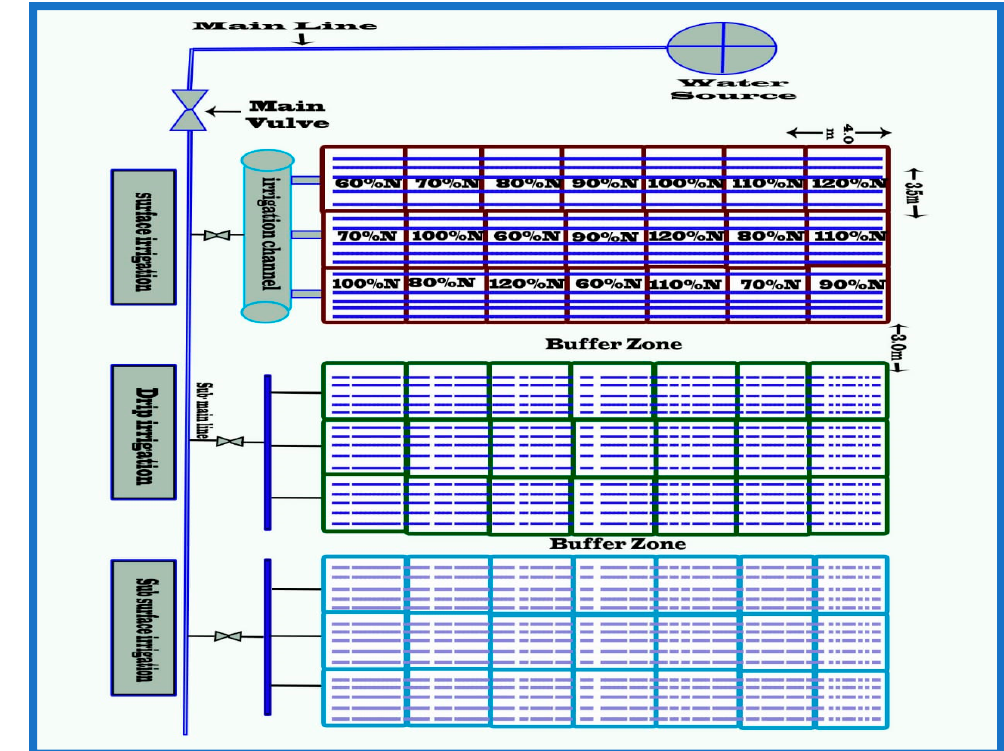
Figure 1. Layout of the experimental design.